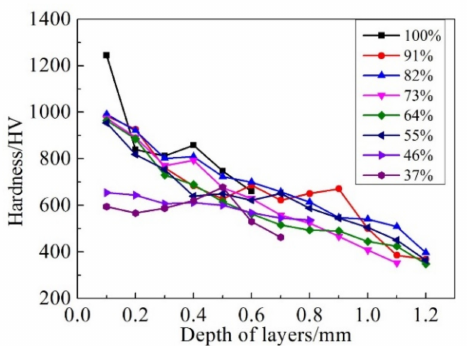
Figure 4. Hardness (HV) curves of the nitrided layer cross section in di ff erent nitrogen–argon gas atmospheres. The percentages represent the amount of nitrogen in the atmosphere; for example, 100% is pure nitrogen, and 37% is 37% nitrogen and 63% argon.